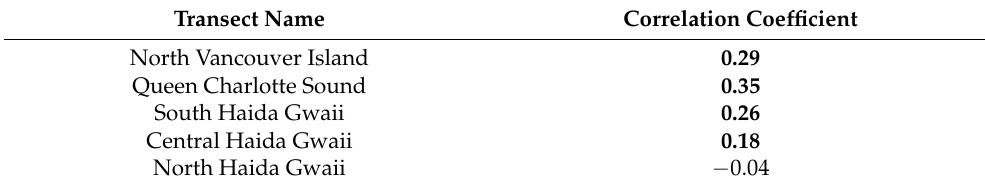
Table 1. Correlation coefficients between the seasonal anomalies of longshore surface currents at the South Vancouver Island transect and those at the other transects. The values statistically significant at the 95% confidence level are bold.